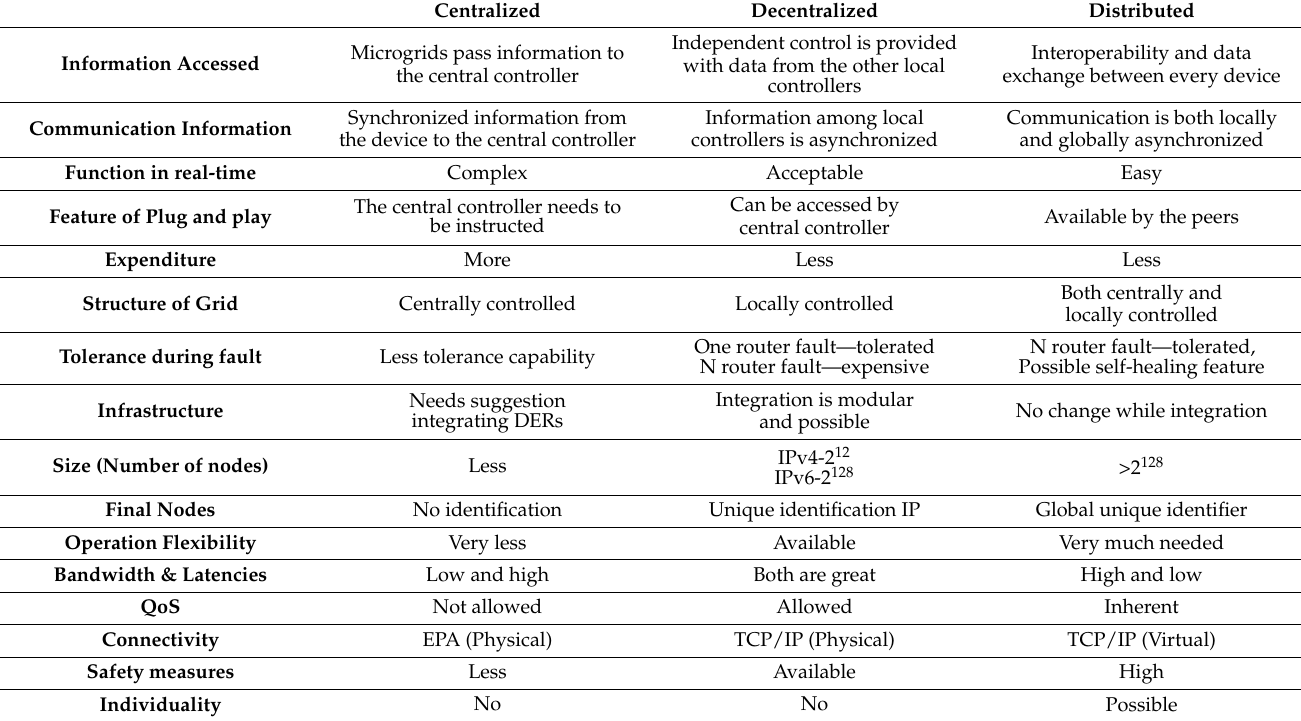
Table 4. Characteristics of different types of controls in the energy management